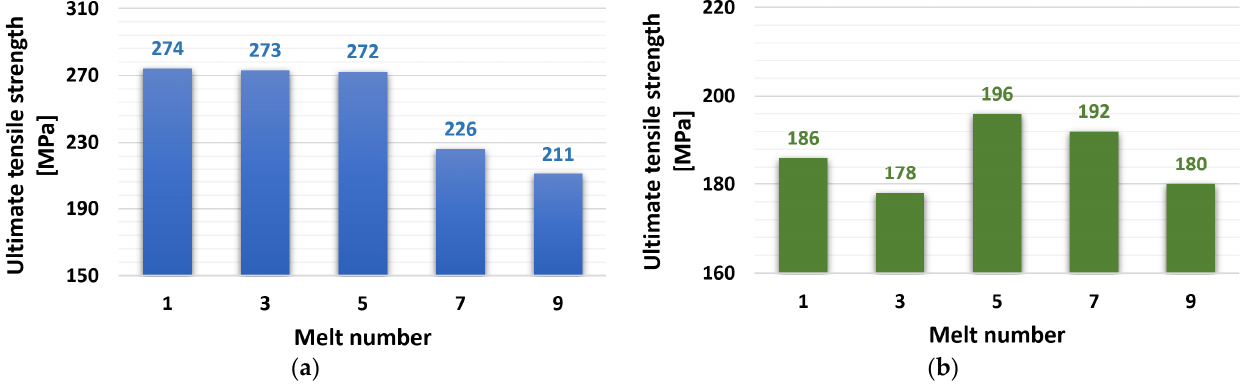
Figure 4. Dependence of ultimate tensile strength on the number of remelts: ( a ) ZnAl4Cu3-P1 to P9 alloys and ( b ) ZnAl4Cu3 with 3 wt.% Cd addition C1 to C9 alloys.